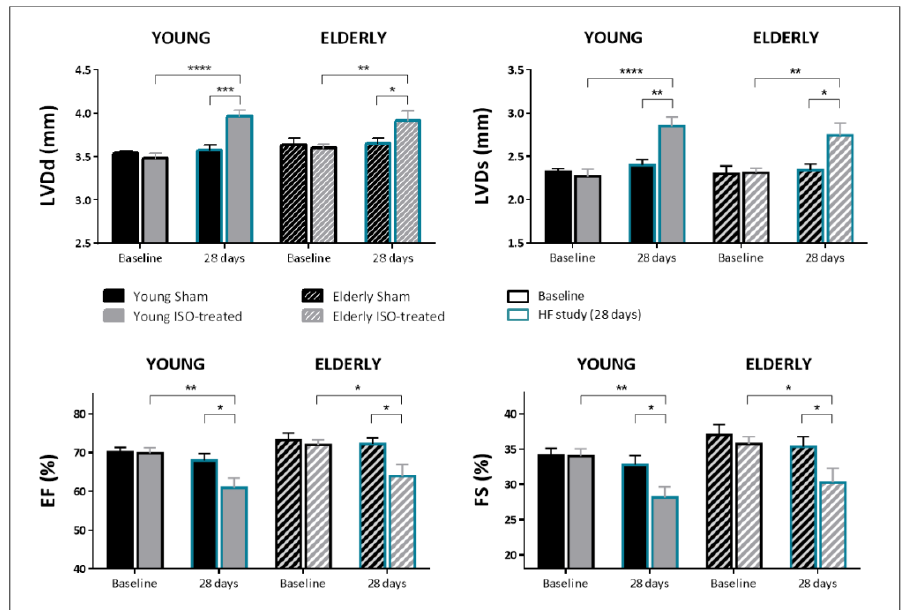
Figure 1. Echocardiographic parameters at baseline (black outlined bars) and after 28-day exposure to saline or isoproterenol infusion (blue outlined bars) in young and elderly mice. LVDd: End-diastolic left ventricular diameter; LVDs: End-systolic left ventricular diameter; IVS: interventricular septum thickness; PW: posterior wall thickness; EF: ejection fraction; FS: fractional shortening. N = 13 in both groups of young mice, and N = 14 in both groups of elderly mice. * p < 0.05, ** p < 0.01, *** p < 0.001, **** p < 0.0001.